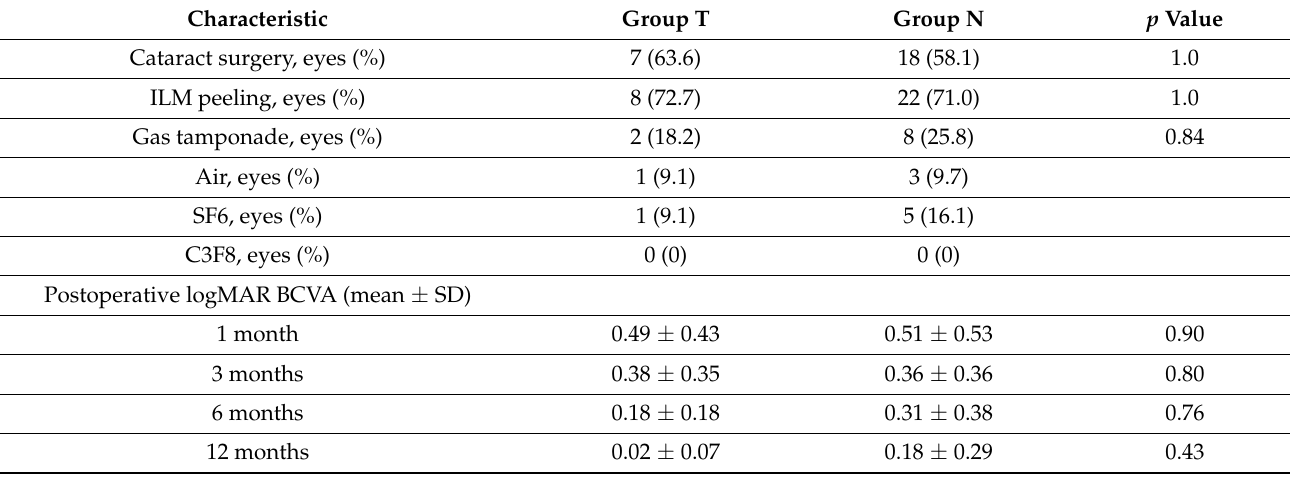
Table 3. Postoperative clinical